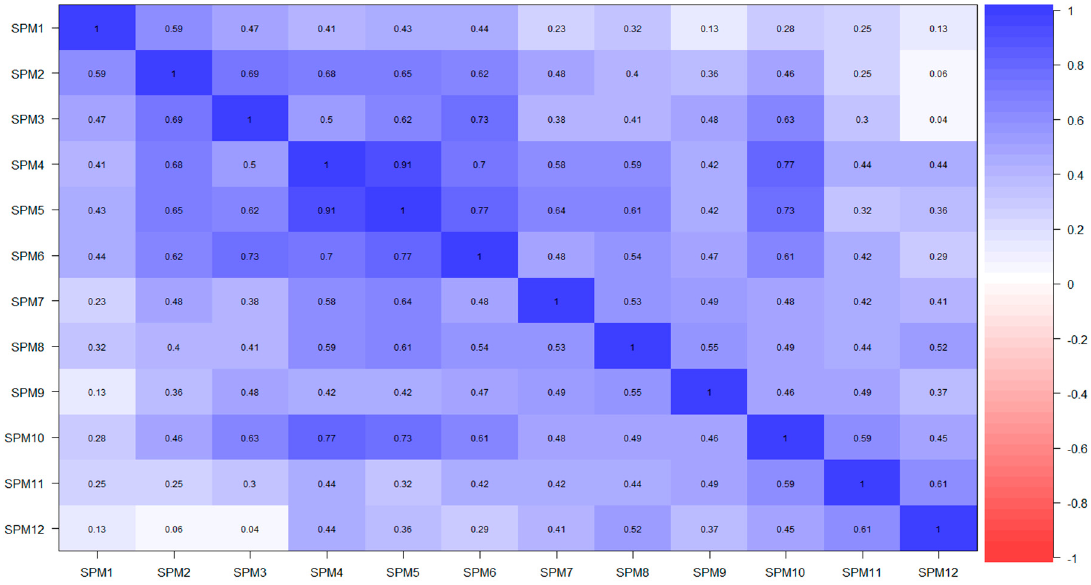
Figure 3. Heatmap of SPM-LS items tetrachoric correlation.